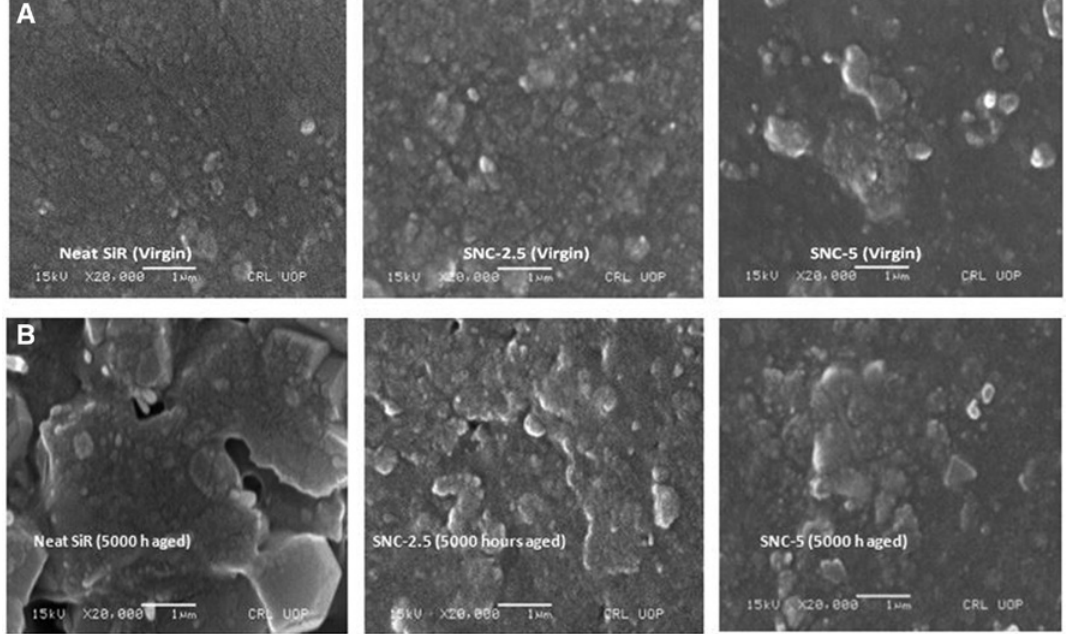
Figure 11: SEM images virgin of 5000 h aged samples of neat SiR, SNC-2.5, and SNC-5: (A) virgin and (B) 5000 h aged.